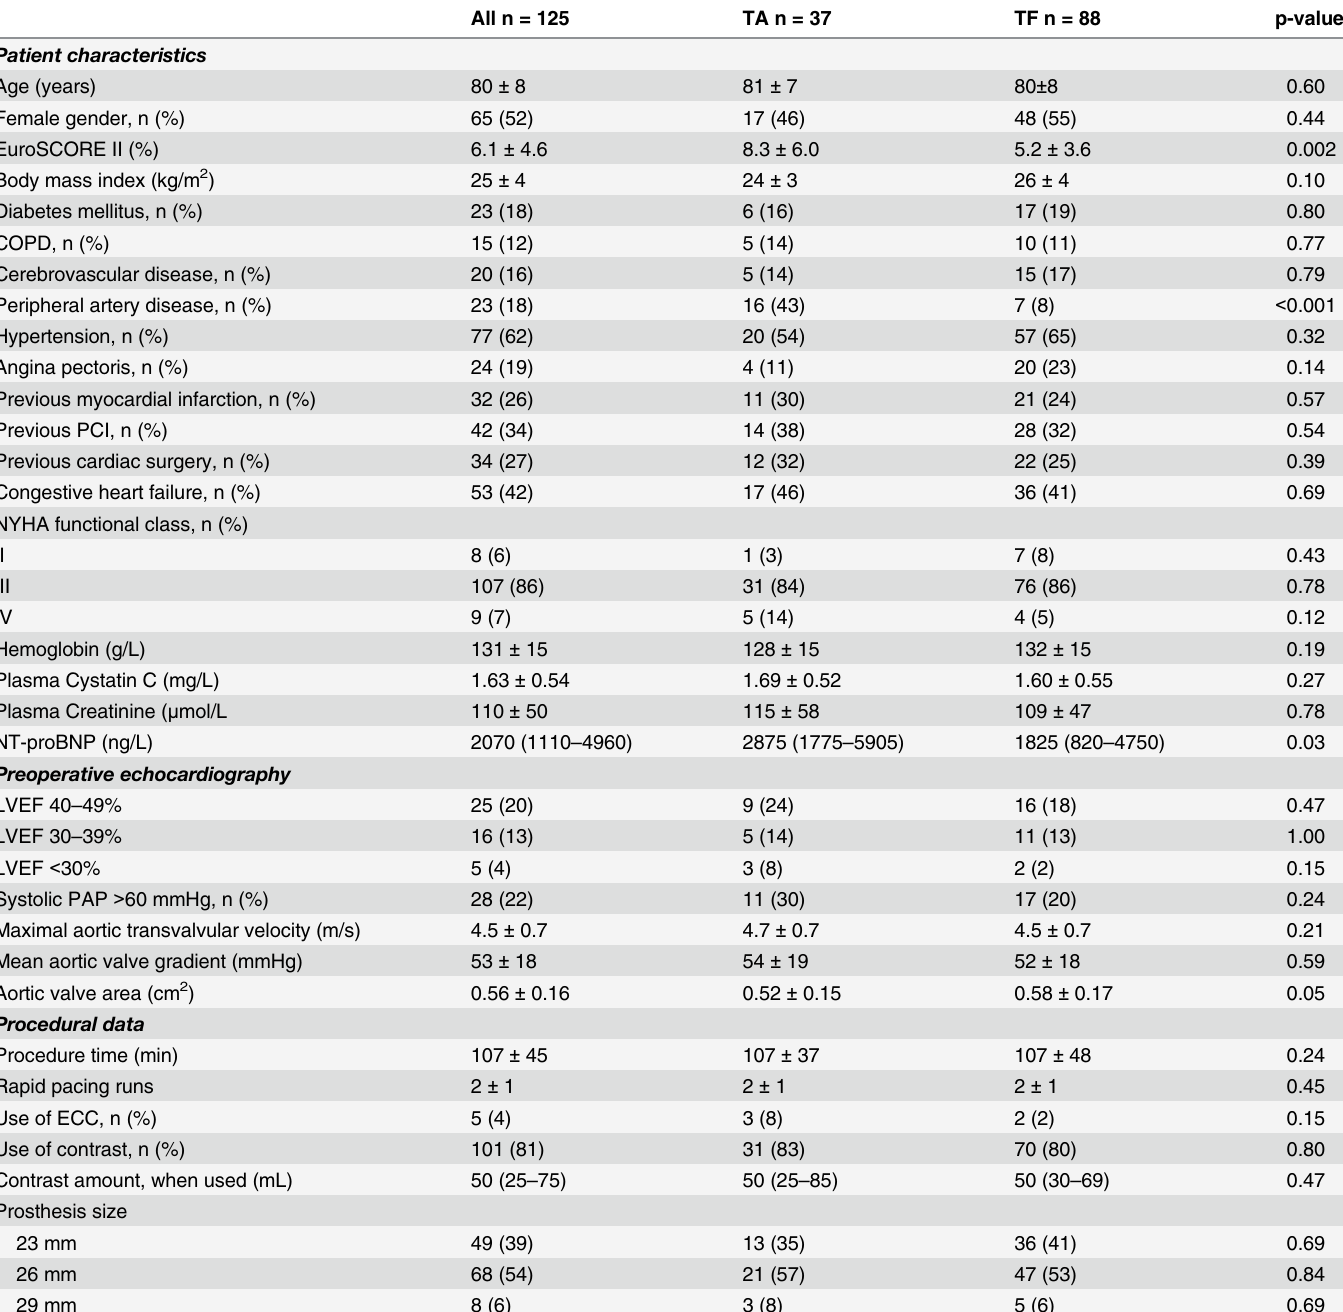
Table 1. Baseline patient characteristics and procedural